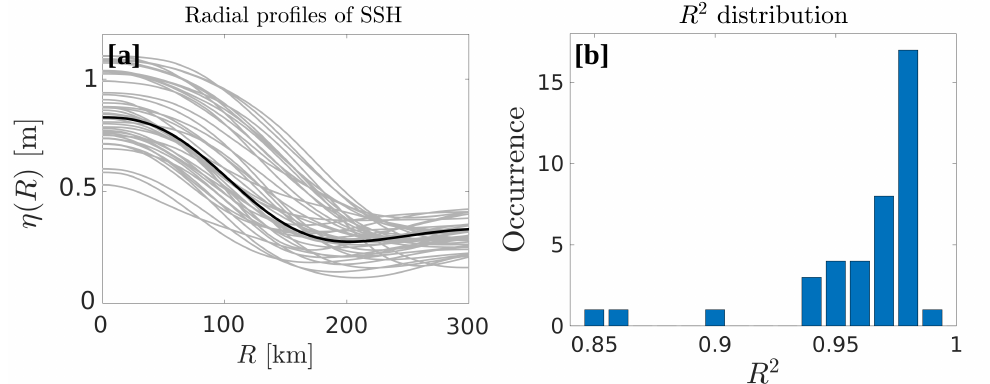
Figure 9. ( a ): Radial profiles of sea surface height (SSH) for the 40 detached Loop Current rings (LCRs) (gray lines) and mean universal SSH profile (Equation (3)) computed using the mean parameters of the 40 least-square fits (black line). ( b ): Coefficient of determination ( R 2 ) of the observed SSH profiles and the fitted universal